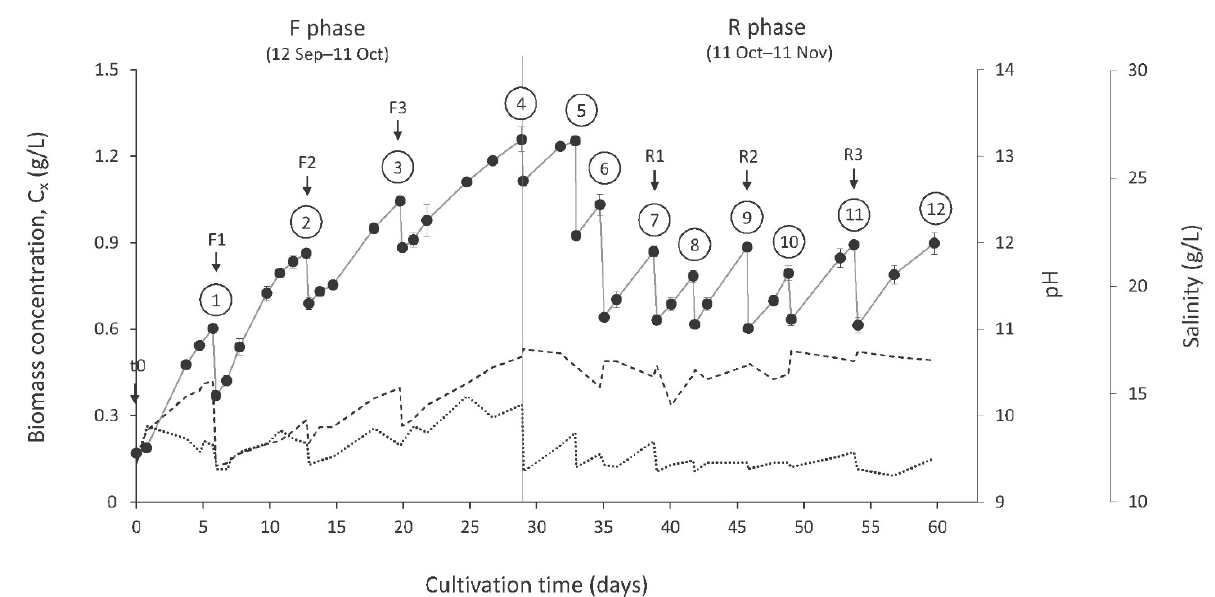
Figure 1. Biomass concentration (C x , g/L; solid line), pH (dashed line) and salinity (dotted line) of the A. platensis BEA 1257B culture in function of the time-course of the semi-continuous cultivation in the 8000 L raceway pond inside greenhouse during the experimental phases F (12 Sep. to 11 Oct.) and R (11 Oct. to 11 Nov.). Vertical solid line indicates the end of the F phase and the beginning of the R phase. Each harvest (performed at the end of each semi-continuous cycle) is indicated with the number tag. There were four harvests in a 29-day period during F phase, and eight harvests in a 31-day period during R phase, i.e., 12 cumulative harvests in 60 days. Black arrows indicate times in which the biomass was collected for analysis: the three samples F1, F2 and F3 were collected during the F phase, while the three samples R1, R2 and R3 were collected during the R phase; sample t0 was collected at the beginning of the experiment and was excluded from calculations and statistical